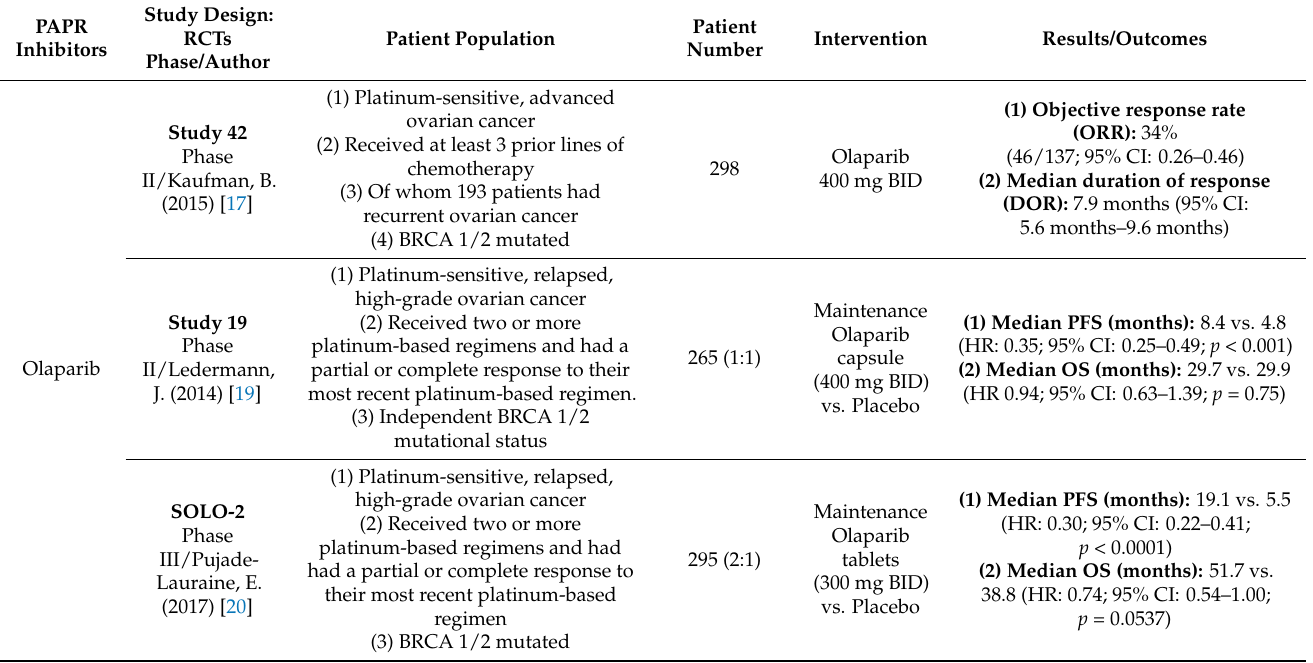
Table 2. A summary of randomized trials of PAPR inhibitors, including olaparib, rucaparib, and